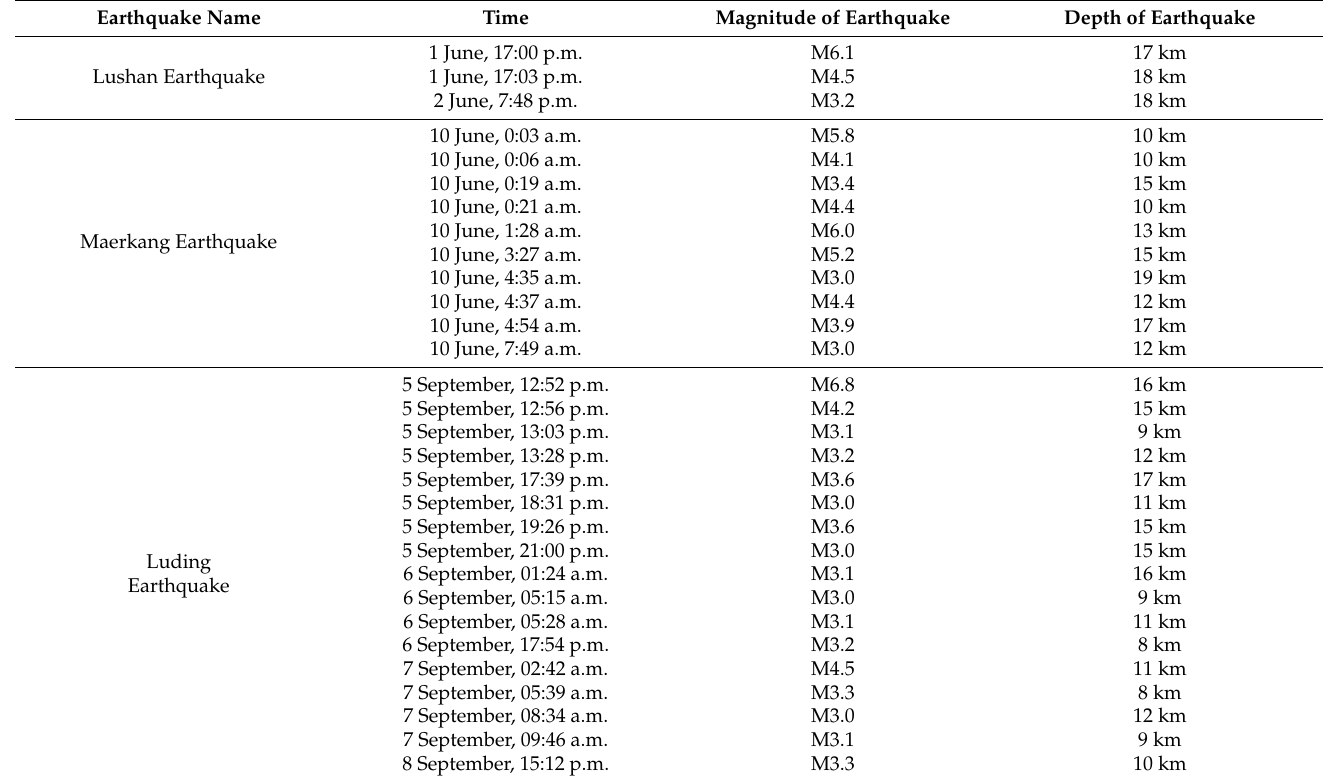
Table 1. Earthquake Occurrence